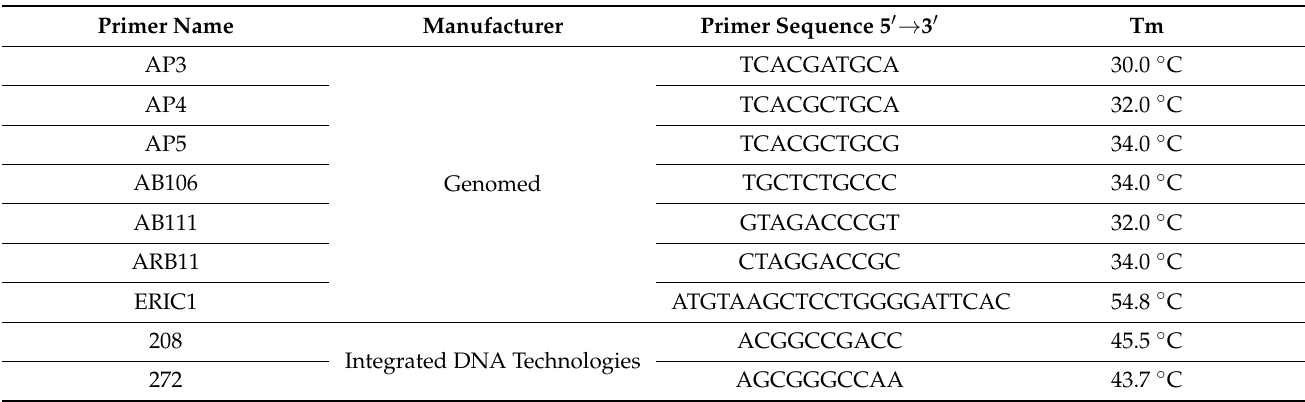
Table 1. Specification of the primers applied in this